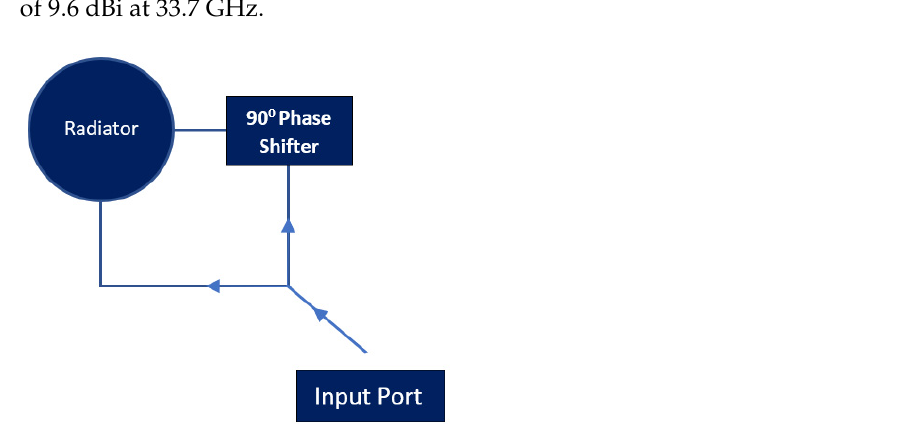
Figure 1. Topology of the proposed CP patch antenna via two feeding points separated through the quarter wavelength.